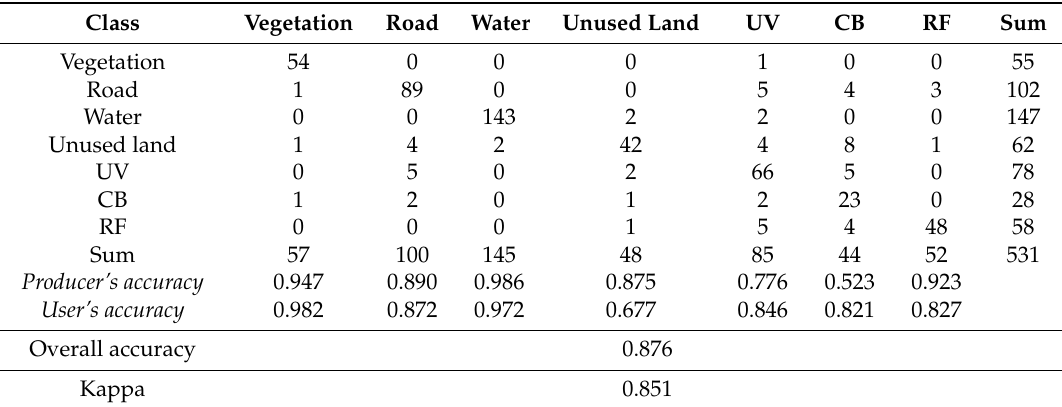
Table 4. Confusion matrix of land